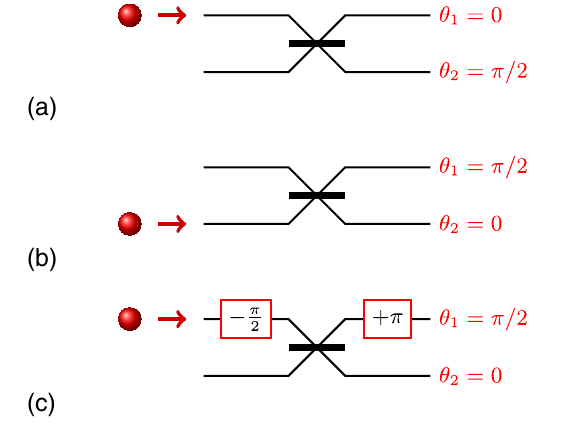
FIG. 8. (a) A photon that enters the upper port of a beam splitter, according to our modeling [Eq. (A1)], acquires θ 1 ¼ 0 phase delay when exiting on the upper port, and θ 1 ¼ π = 2 phase delay when exiting on the lower port. (b) A photon that enters the lower port has the symmetric behavior. (c) Suitable phase shifters, placed on the input and output ports, make a photon entering the upper port to acquire the same phase delays as if it entered the lower one.